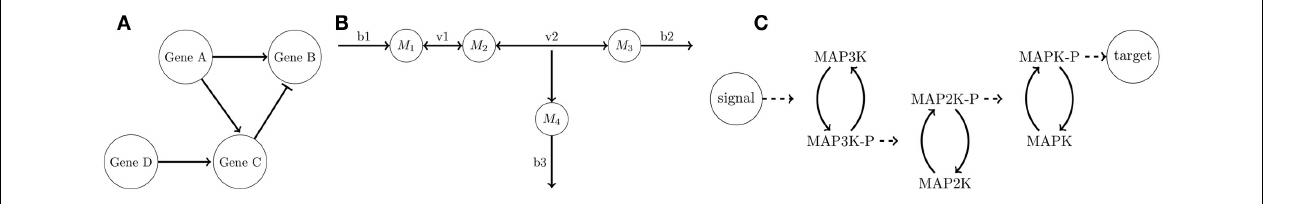
FIGURE 3 | Graphical representation of (A) gene-regulatory network, (B) metabolic network, and (C) signaling network. (A) The activation of genes is shown by arrows whereas repression is marked by bars. (B) Metabolites